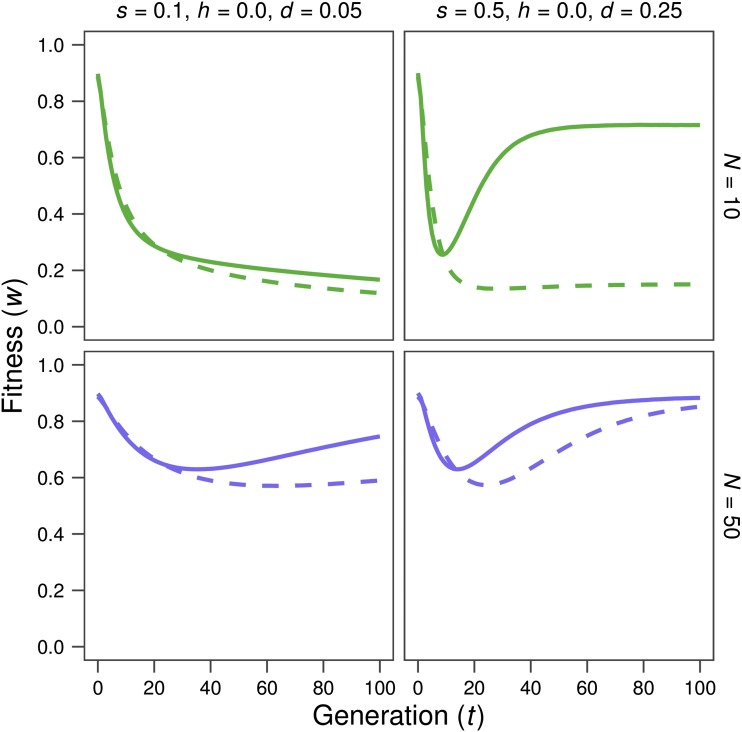
Evolution of average fitness after a reduction of population size (N = 10, green; N = 50, blue) under no recombination or tight linkage. Simulation results for the decline of fitness under free recombination (solid lines) or a genome length of L = 1 Morgan (dashed lines).